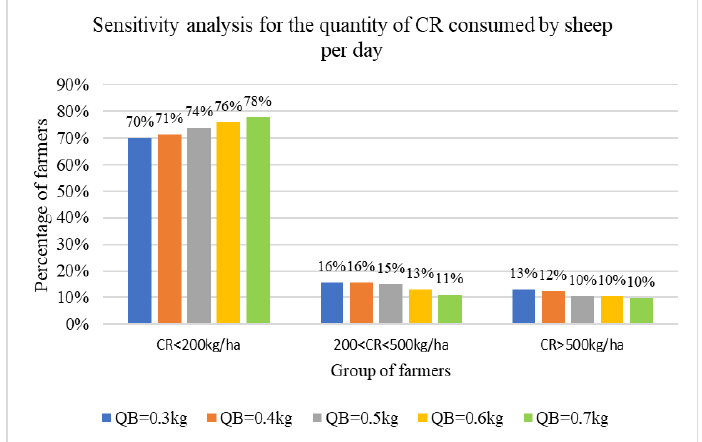
Figure 4. Sensitivity analysis for the quantity of residues biomass consumed per sheep per day; (QB: quantity of residues biomass consumed per sheep per day).